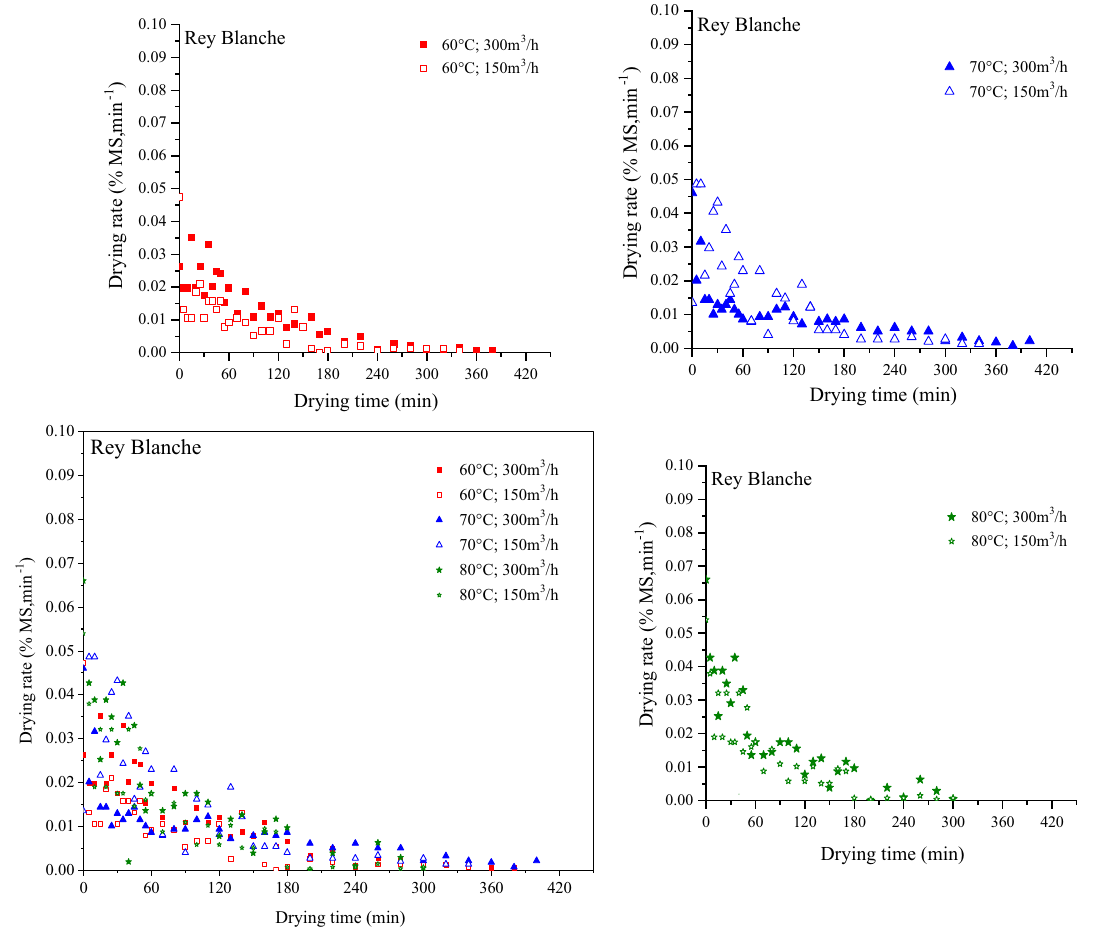
Figure 5. Drying rate of fig slices as a function of drying time. Curves for each temperature are embedded